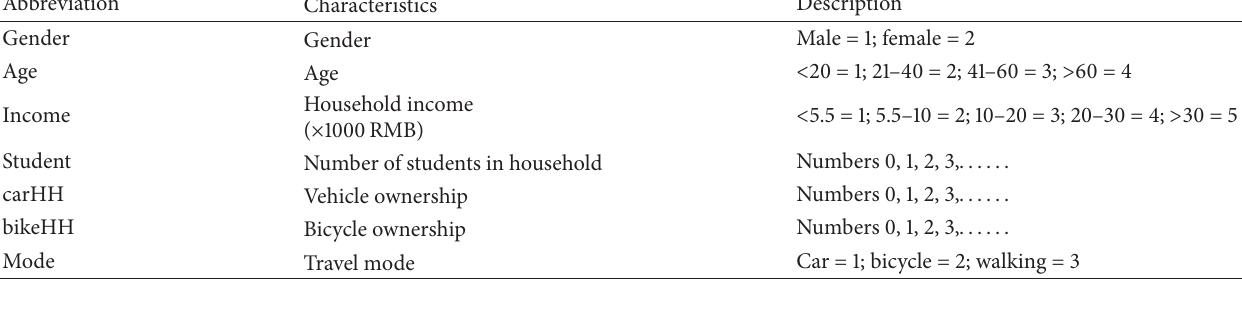
Table 2: Descriptions of model variables.